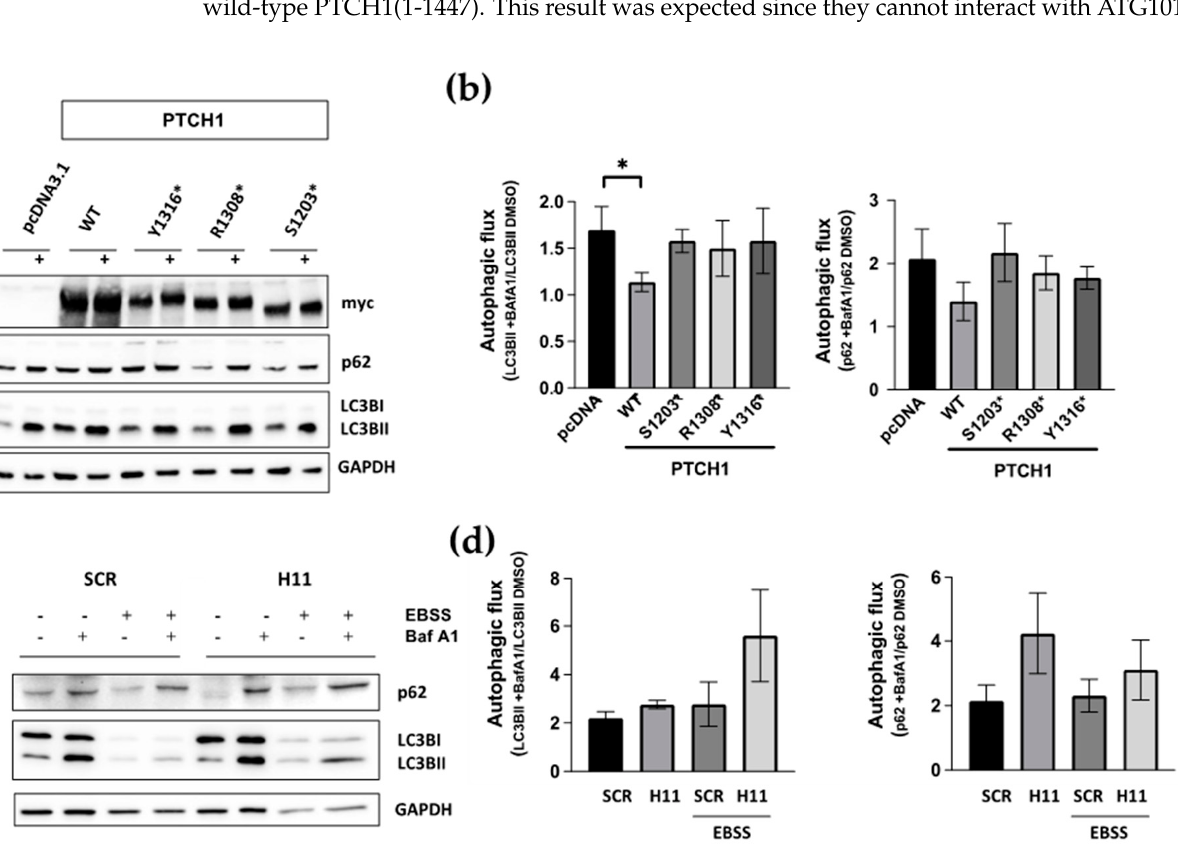
Figure 2. The ATG101 interacting region of PTCH1 is necessary for autophagic flux inhibition. ( a ) HEK293 cells were transfected with WT PTCH1 or the indicated variants. After 20 h, 100 nM Bafilo- mycin A1 (Baf A1) or the same amount of DMSO were added for an additional 4 h, before lysing the cells and determining the levels of p62/SQSMT1 (p62) and LC3BI and II; ( b ) Autophagic flux determination from densitometric analysis of the change in the level of LC3BII and p62 normalised to GAPDH in cells expressing the different PTCH1 mutants in the presence and absence of bafilo- mycin A1. Data represent the mean +/ − SEM of 3 biological replicates, * p < 0.05; ( c ) Autophagy markers levels in CRISPR/Cas9 engineered HEK293 cells expressing endogenous wild-type PTCH1 (SCR) and PTCH1 D1222fs (H11) under standard growth conditions or after 4 h of nutrient starva- tion (EBSS); ( d ) Autophagic flux determination from densitometric analysis of the change in the level of LC3BII and p62 normalised to GAPDH in SCR and H11 cells in the presence and absence of bafilomycin A1. Data represent the mean +/ − SEM of 3 biological replicates. All the whole western blot figures can be found in the supplementary materials. To confirm that truncations of the CTD of PTCH1, when expressed from the endog- enous locus, also lose the autophagy inhibitory capacity, we introduced indel mutations in endogenous PTCH1 after S1223 using CRISPR/Cas9 in HEK293 cells. The frameshift takes place after D1222, between the most common cancer indels at S1203 and R1308, due to gRNA design (Supplementary Figure S1). The autophagic flux of PTCH1 CTD mutant cells (H11) was slightly, but clearly, increased compared to isogenic control cells express- ing WT PTCH1 (SCR) (Figure 2c,d). The enhanced effect of Bafilomycin A1 was observed on basal autophagy when cells were grown in a complete medium, as well as when in- duced by amino acid starvation by incubation in EBSS. Taken together, these results indi- cate that the most common cancer-associated CTD truncation mutants are loss-of-function for autophagy regulation by loss of interaction with ATG101. 3.4. Truncation of the CTD in Endogenous PTCH1 in Colorectal Cancer Cells Increases Autophagic Flux and Dysregulates Expression of Autophagy-Related Proteins Since the previous findings were obtained with immortalised normal cells, we next investigated whether frameshift-causing mutations of PTCH1 could increase the au- tophagic flux in colon cancer cells. Thus, indel mutations after S1223 were engineered in SW620 cells by CRISPR/Cas9 technology to generate isogenic cancer cell line pairs